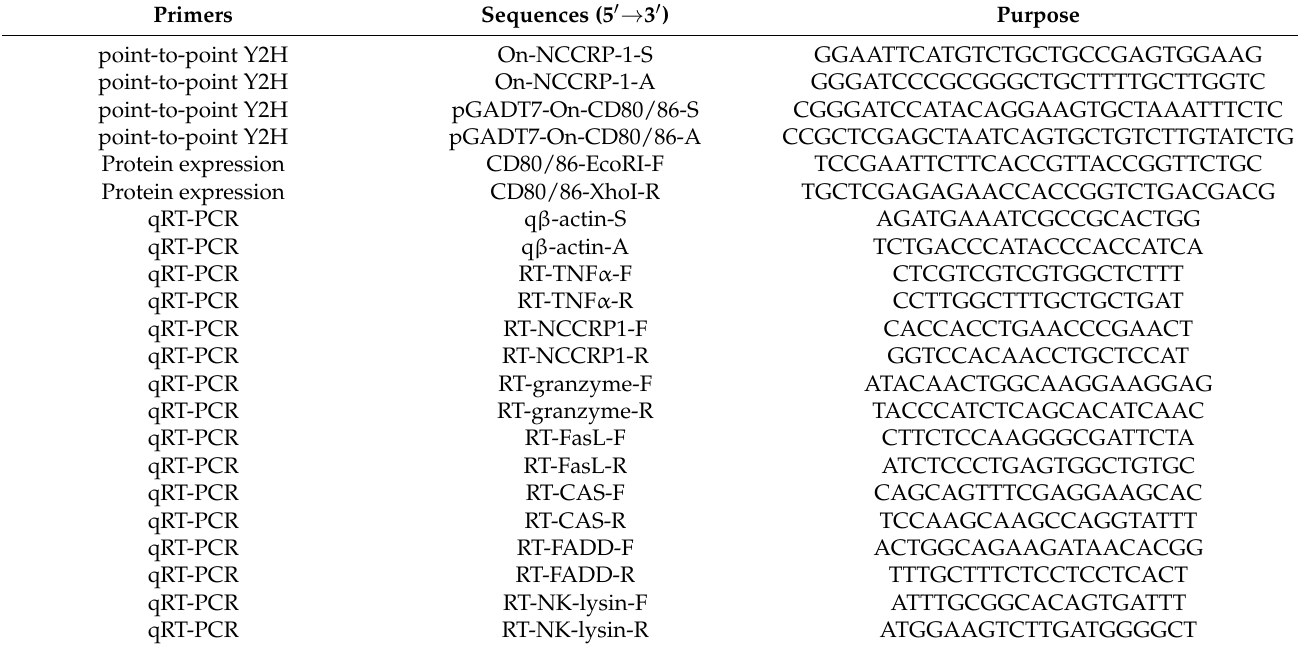
Table 1. Primers used in this